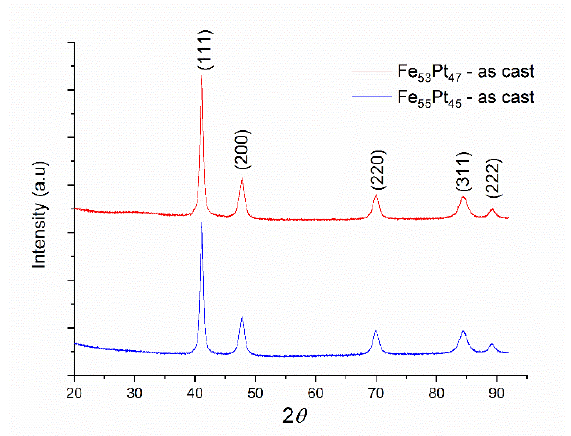
Figure 1. XRD di ff ractograms for Fe 53 Pt 47 and Fe 55 Pt 45 as-milled powders. Figure 1. XRD diffractograms for Fe 53 Pt 47 and Fe 55 Pt 45 as-milled powders.